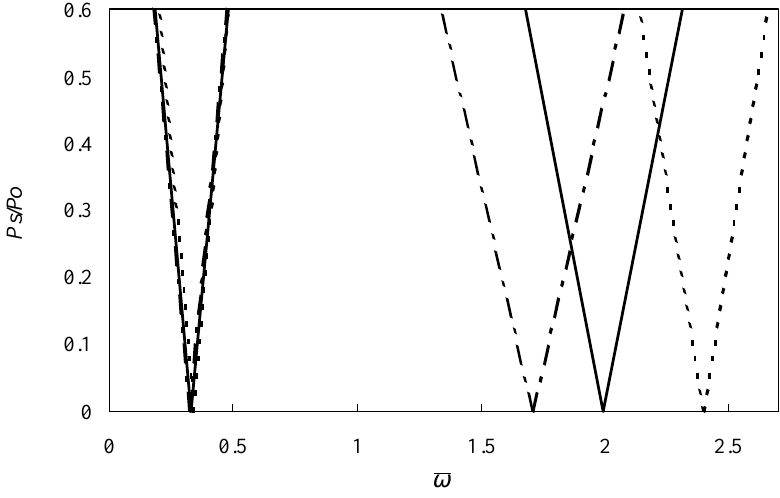
Fig. 7. First two instability regions for a rotating beam with double cracks at x cmean = 0 . 5 L , L = 1 . 0 m and a/h = 0 . 5 . ‘-.-.-’ Ω = 0 . 5 , ‘–’ Ω = 1 , ‘- - -’ Ω = 2 .